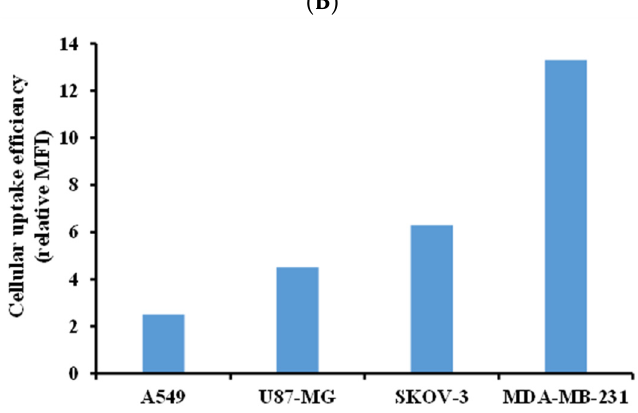
Figure 5. ( A ) Cellular uptake of PLGA-PEG (PP NPs) and PLGA-PEG-maleimide (PPM) NPs-Cys-T7 in four cancer cell lines under 5% CO 2 at 37 °C for 2 h analyzed by flow cytometer (n = 3, mean ± SD, * p < 0.05, ** p < 0.01, *** p < 0.001, compared to PP NPs). ( B ) Cellular uptake efficiency of PPM NPs-Cys-T7 (relative MFI calculated by Equation (3)) at 1.5 mg/mL in four cancer cell lines.